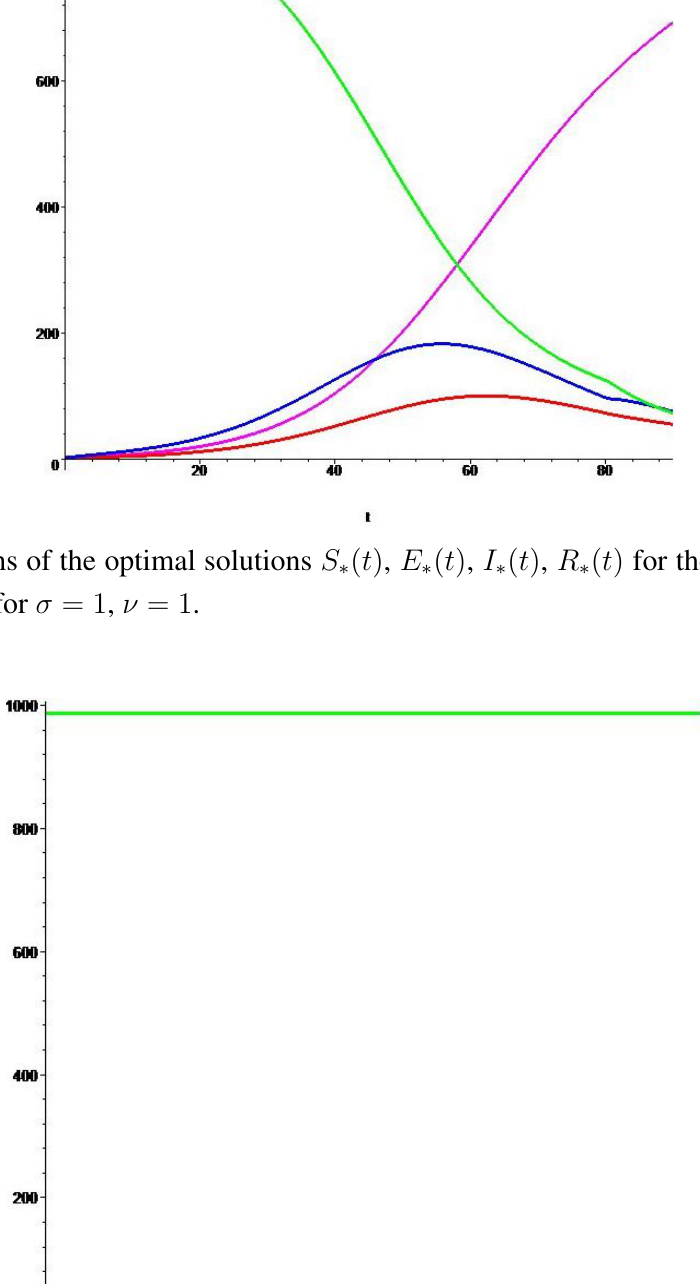
Figure 2. Graphs of the optimal solutions S in Uganda (2000) for σ = 10 , ν = 10